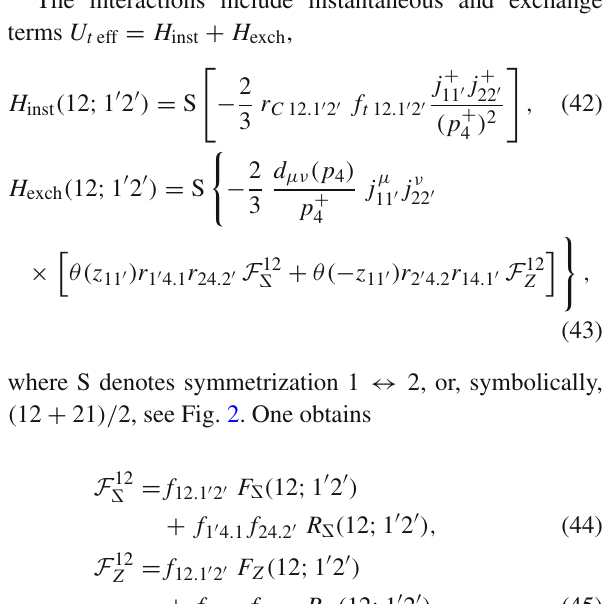
The interactions include instantaneous and exchange